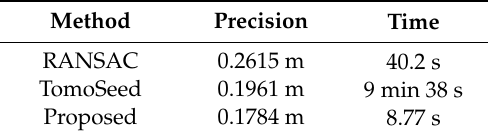
Table 1. Reconstruction precision and time cost obtained by a regular desktop PC (Core i5-7200U). A lower number indicates a better performance. The time does not include the time expended on data splitting and splicing in RANSAC and TomoSeed.